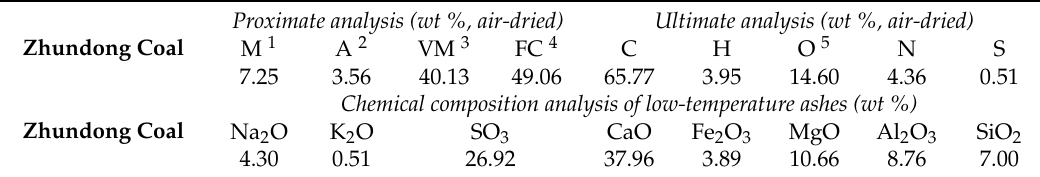
Table 2. Proximate, ultimate and ash composition analysis of Zhundong